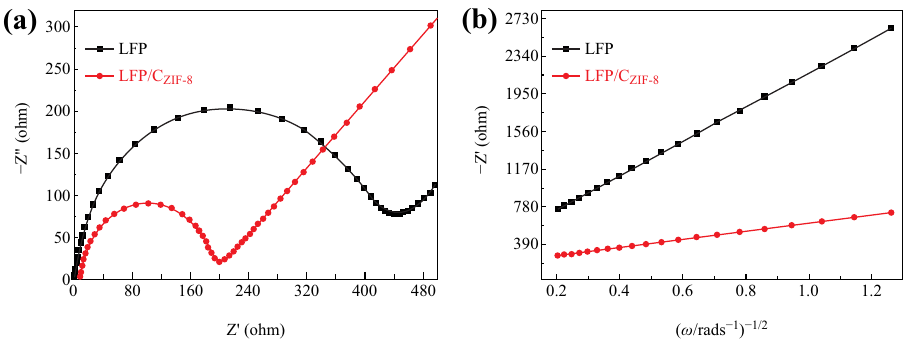
Fig. 5 a Nyquist plots of LFP and LFP/C ZIF-8 cathodes in EIS curves. b The plots of impedance as a function of the inverse square root of angular frequency in the Warburg